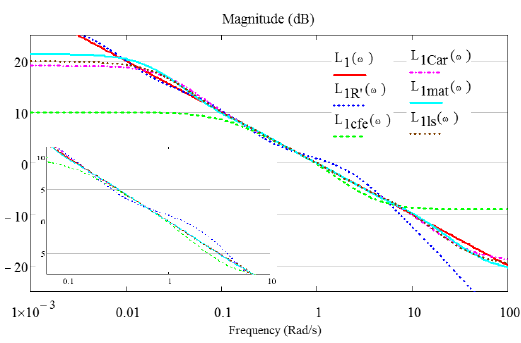
Fig. 3: Magnitude responses